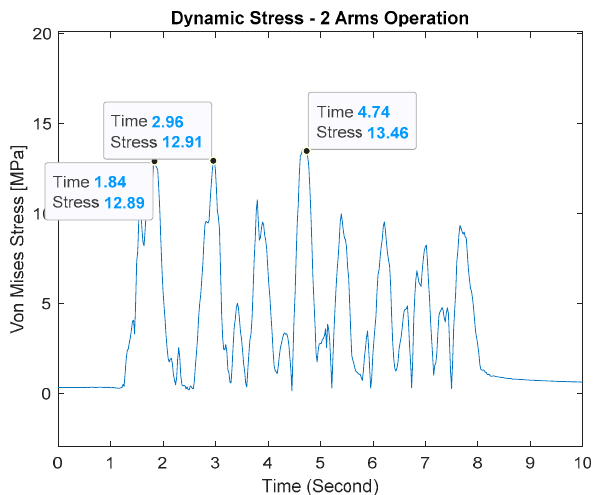
Figure 23 . Dynamic test result (double crank arms operation).